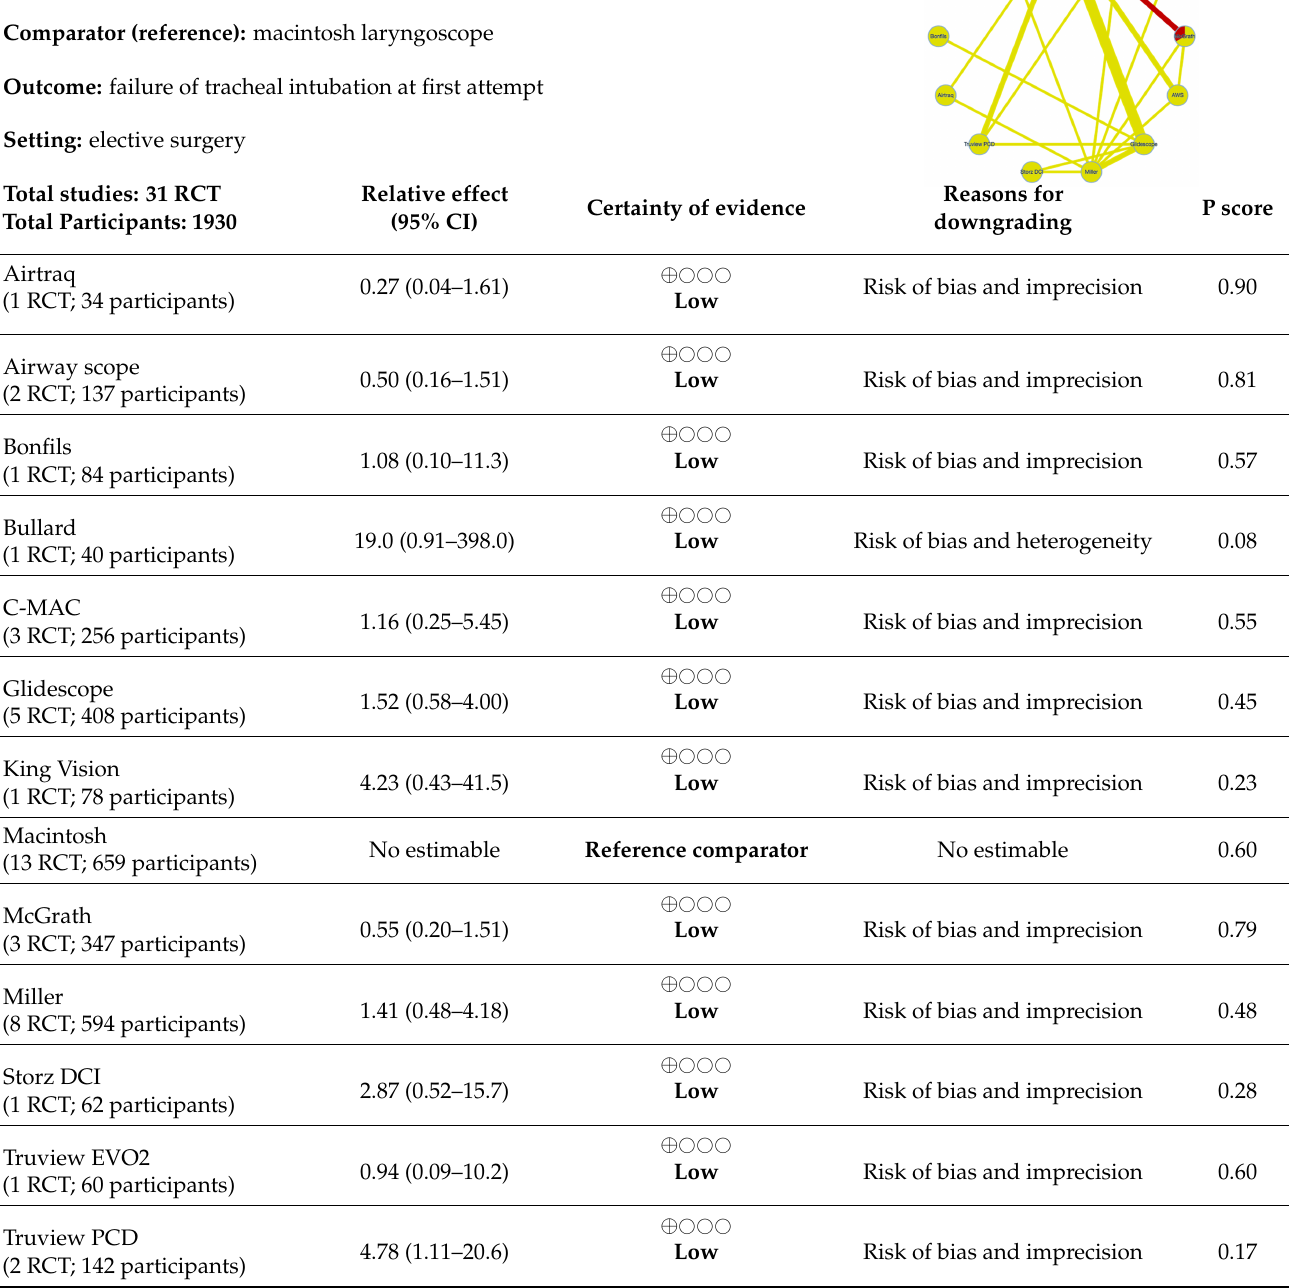
Table 2. Summary of findings table for primary outcome. Figure 3. The results of primary ( A ) and secondary outcome ( B,C ) by P score ranking.